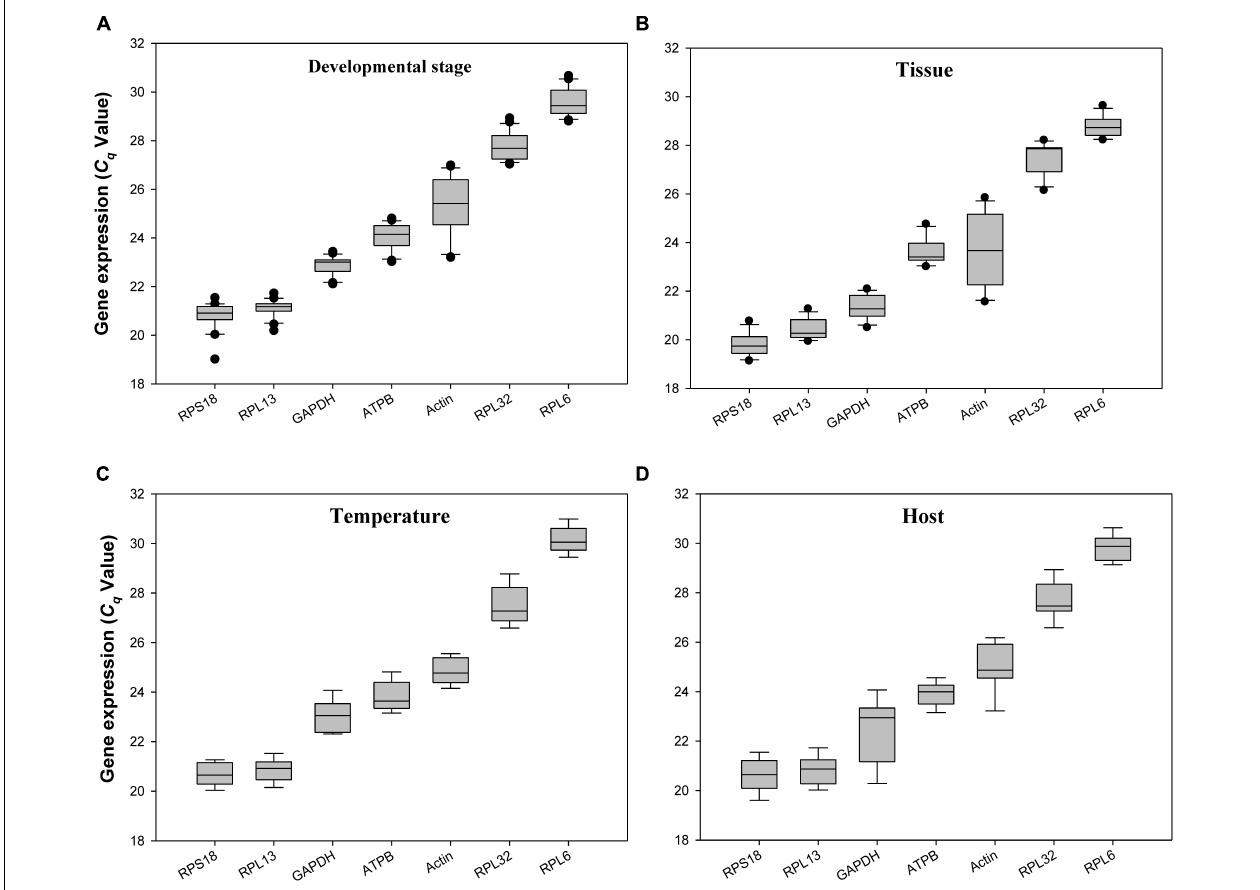
FIGURE 2 | Expression profiles of the 7 candidate reference genes in all 4 experiments for H. vigintioctomaculata . The expression levels of the reference genes are shown in terms of the C q -value for each experimental condition. (A) Development stage, (B) Tissue, (C) Temperature, (D) Host plant.